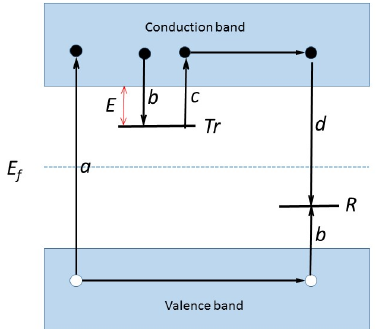
Figure 1. A simplified model of the thermoluminescence mechanism: During the excitation stage (a) electrons and holes are produced which are trapped (b) in trapping, Tr , and Recombination centers, R. During the heating stage (c) electrons are released to the conduction band and move through the Conduction band until they encounter a hole in a recombination center (d). The recombination energy will excite the center and relaxation of the excited center will produce the luminescence. For explanation of E and E f see text.